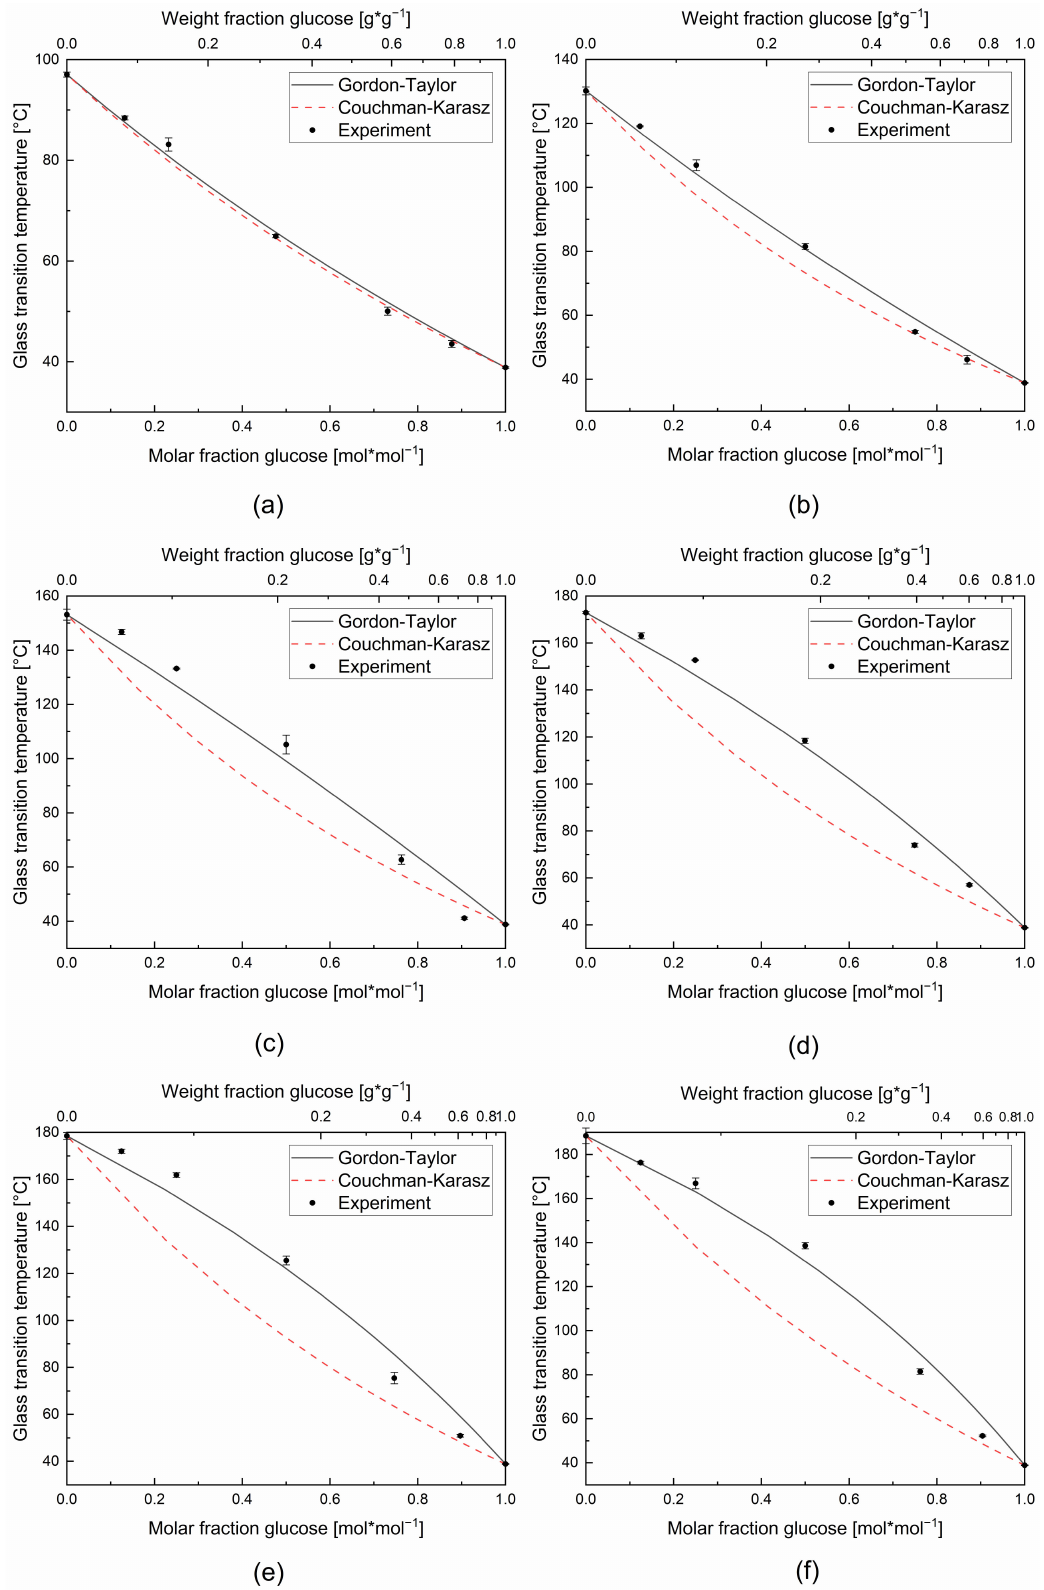
Figure 3. Experimental glass transition temperatures, Gordon–Taylor fit and Couchman–Karasz curve for the investigated, anhydrous binary glucose mixtures with ( a ) maltose, ( b ) maltotriose, ( c ) maltotetraose, ( d ) maltopentaose, ( e ) maltohexaose, and ( f )